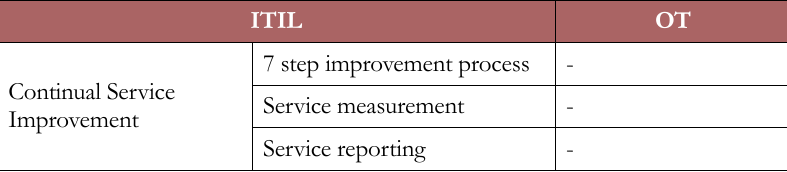
Table 7. High-level continual service improvement ITIL - OT